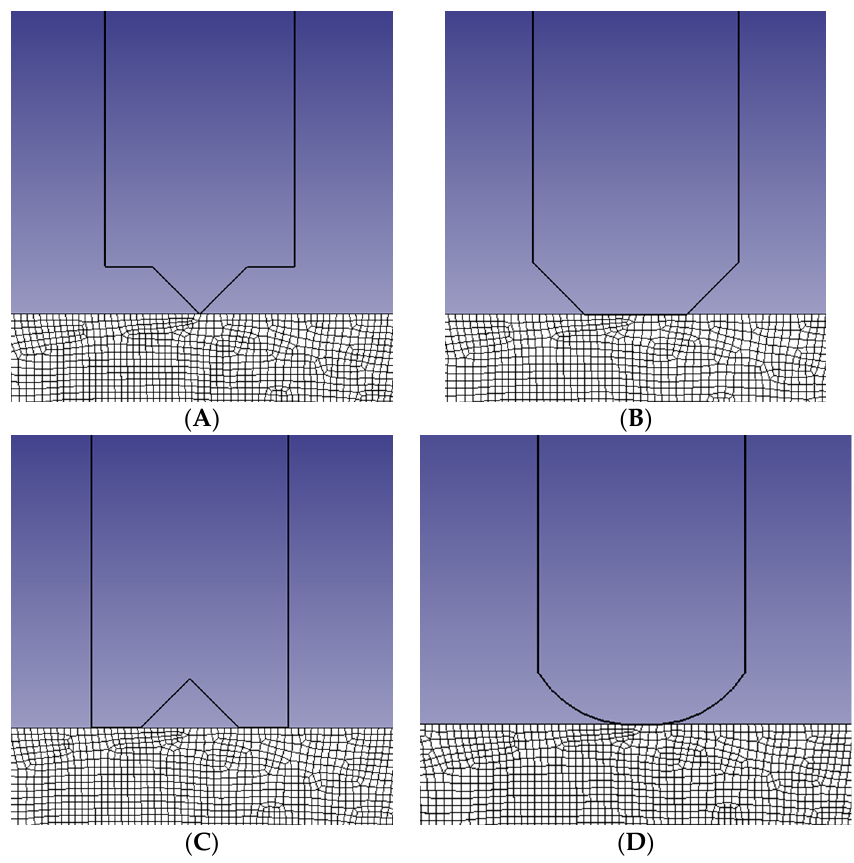
Figure 7. Geometries studied. Flat punch (FP) + inclined punch (IP) ( A ); IP + FP ( B ); inverted punch ( C ) and curve punch ( D ).